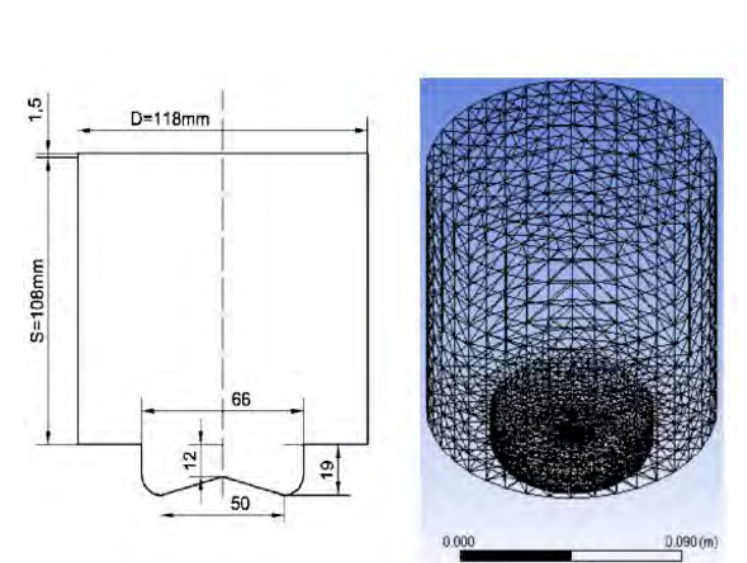
Figure 1. Calculating space and meshing